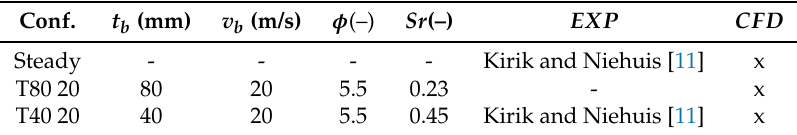
Table 1. Investigated configurations for the T106Div-EIZ.